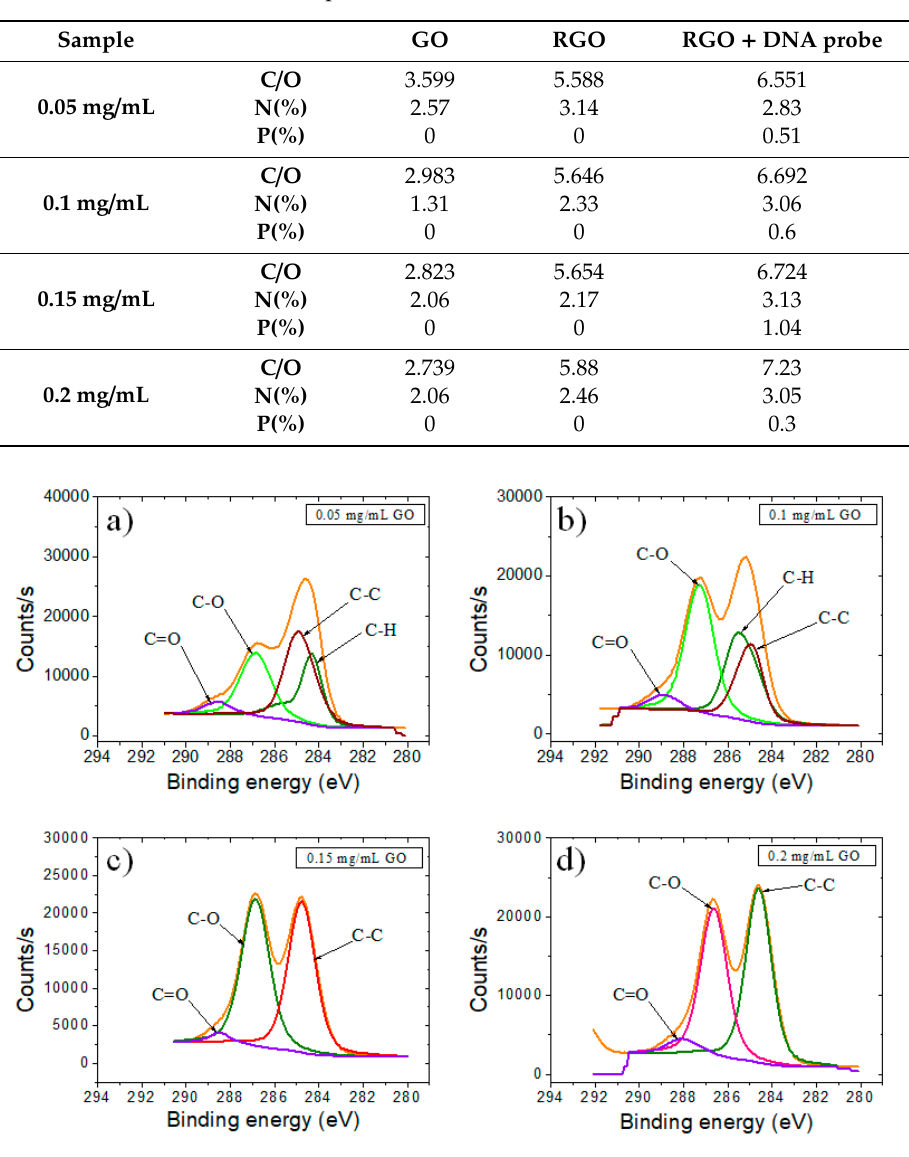
Figure 3. High-resolution C1 XPS spectra of SPCE modified with ( a ) 0.05 mg/mL GO; ( b ) 0.1 mg/mL GO; ( c ) 0.15 mg/mL GO; and ( d ) 0.2 mg/mL GO.